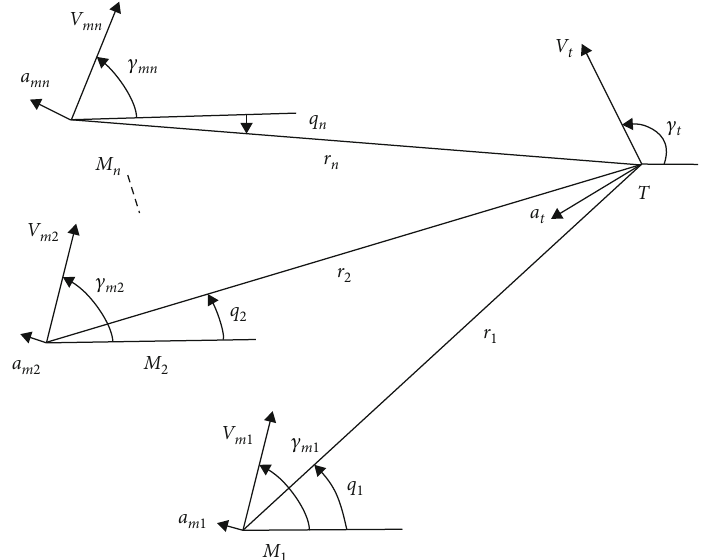
Figure 1: Homing engagement